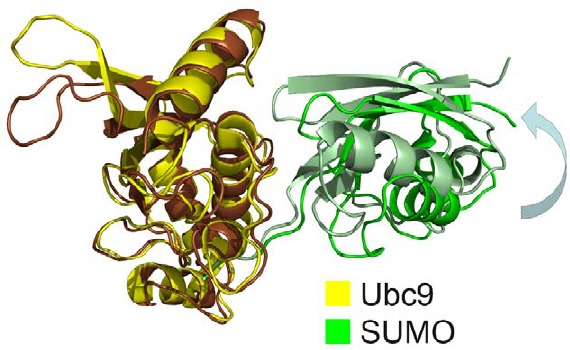
Figure 3. SUMO orientation change. The orientations in the crystal structure [20] (Ubc9 in yellow and SUMO in dark green) and a representative structure from the simulation trajectory (Ubc9 in brown, SUMO in light green) are aligned via the Ubc9 molecule. The orientation change in SUMO can clearly be seen. Additionally, the motion of the mobile loop of Ubc9 (Val27-Met39) can also be